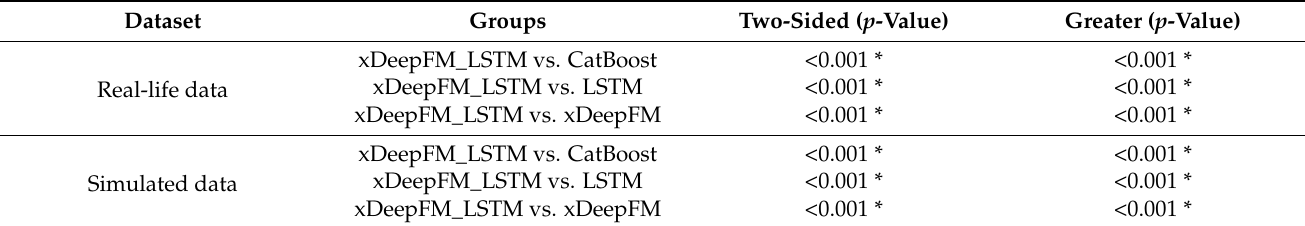
Table 3. The results of KSPA